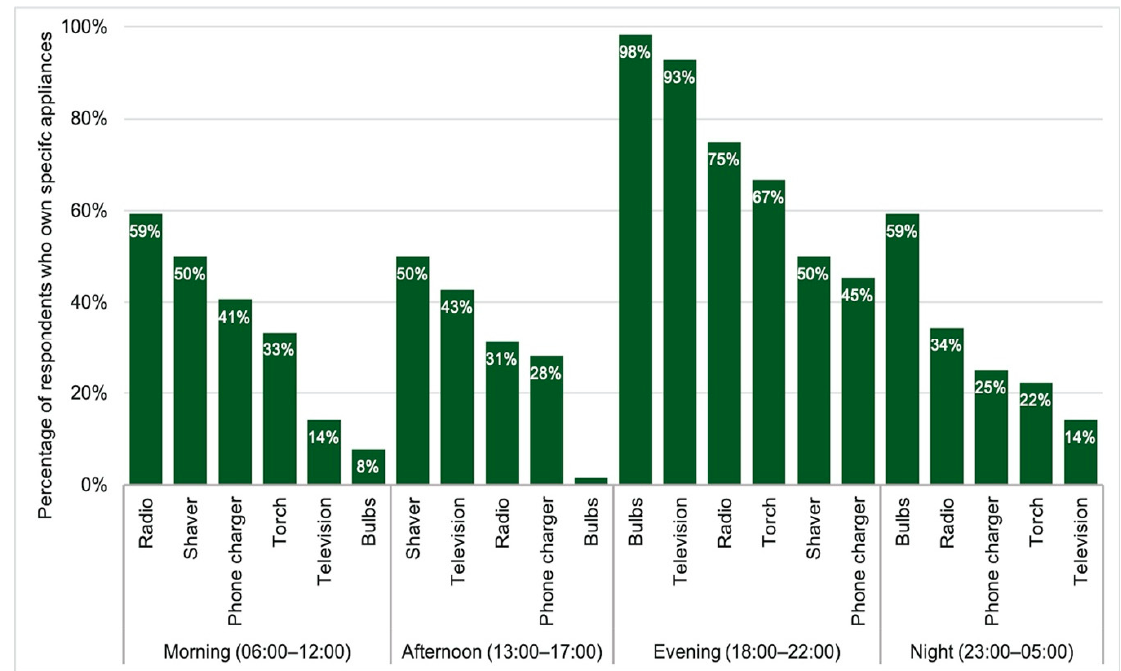
Figure 6. Average appliance usage throughout the day as a percentage of appliance owners.